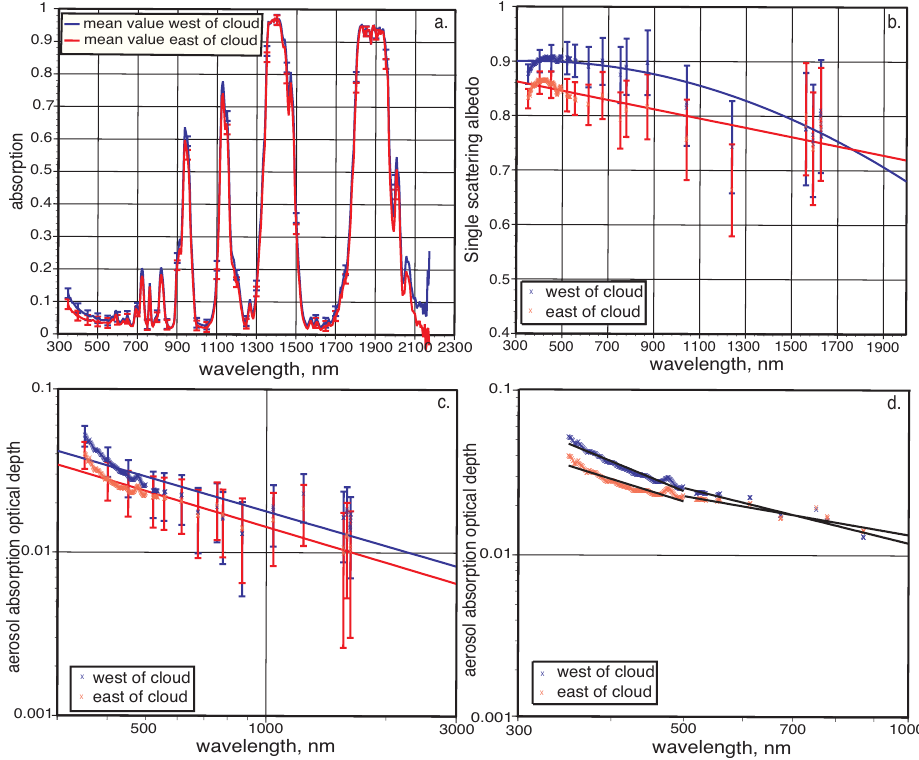
Fig. 3. (a) : Fractional absorption, (b) : Aerosol single scattering albedo, (c) and (d) : aerosol absorption optical depth for 13 March 2006. SSFR and AATS data were obtained above and below the aerosol layer along the region between A and B. We hy- pothesize that the region from point A to the location of the cloud/fog remnant in Fig. 2b had been affected by the cloud/fog layer shown in Fig. 2a and that the region east of the cloud remnant in Fig. 2b was unaffected by the